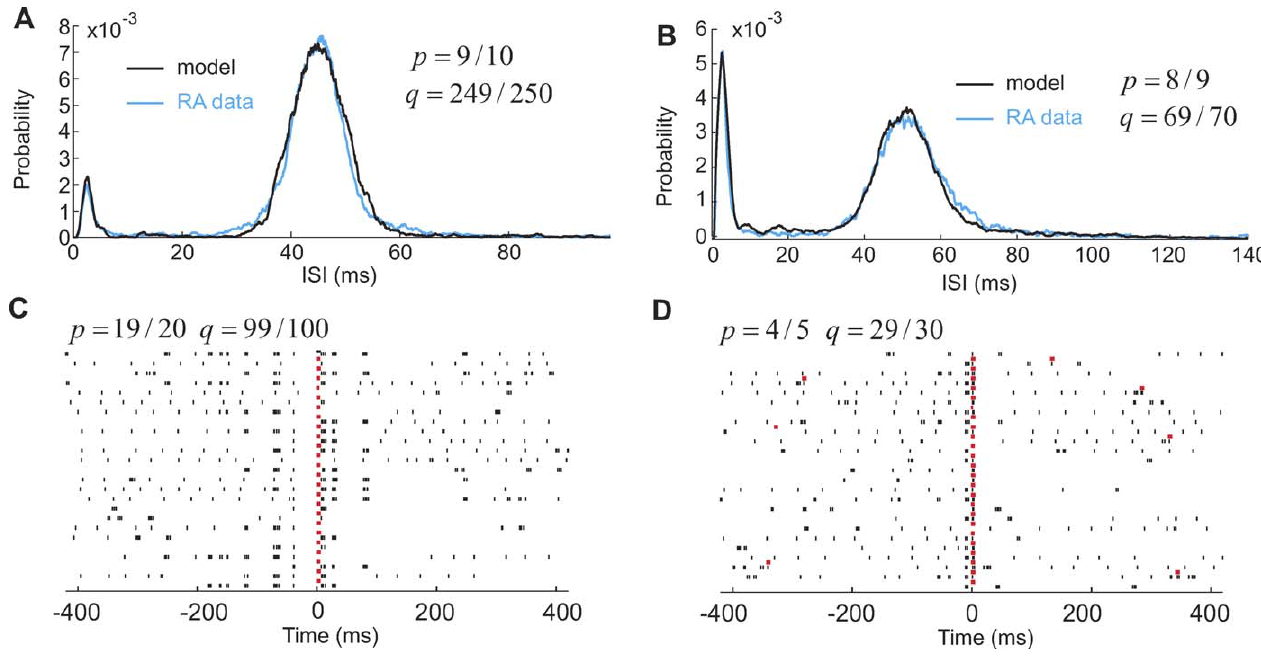
Figure 4. Modeling Sleep-Related Activity ( p,q , 1) (A) An RA neuron producing few burst ISIs. A good fit is produced when the survival time of the ground state is long, compared to that of song states (light sleep, q much closer to 1 than p ). D R ¼ 80 ms, and V R ¼ 0.7. (B) A different RA neuron producing many burst ISIs. A good fit was produced by a relatively long survival time of sleep states (deep sleep). D R ¼ 120 ms, and V R ¼ 0.67. (C,D) Spike raster plots of HVC RA and RA neurons. All HVC RA bursts (red rasters) are aligned at the center of the plots. Corresponding RA spikes (black rasters) are shown below each HVC RA burst. When p is large (strongly coherent sleep) (C), stereotyped RA bursting is observed over larger intervals than when p is small (D).